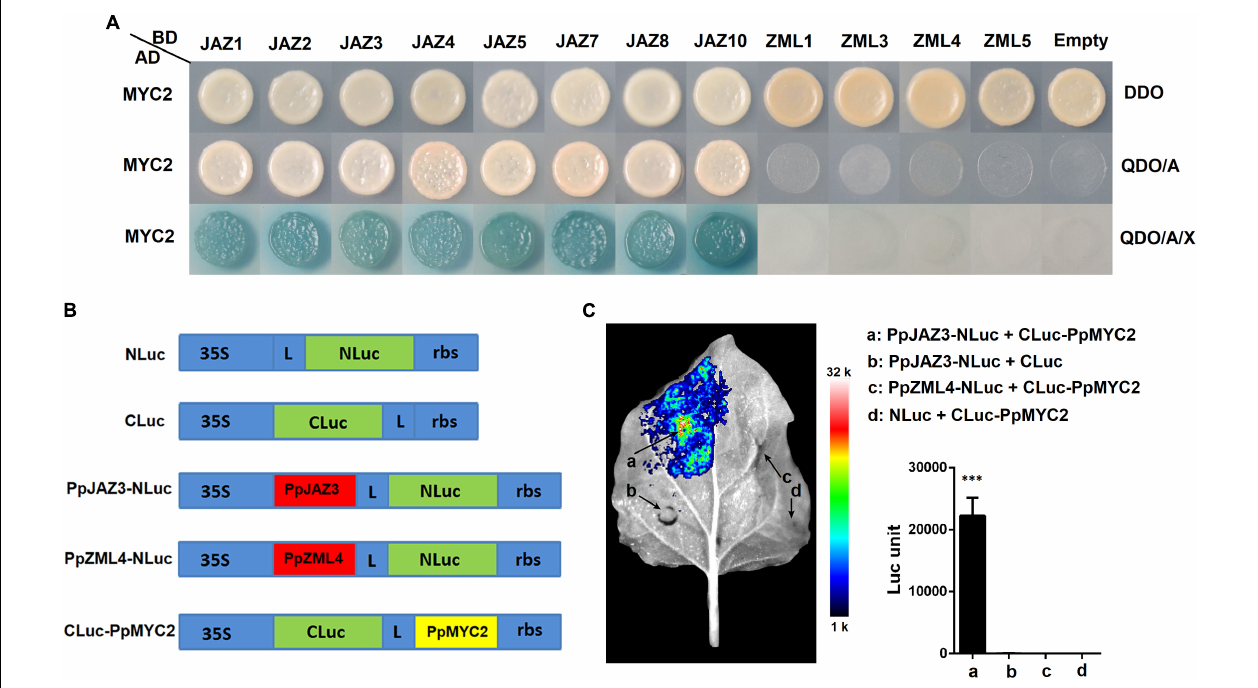
FIGURE 8 | Protein-protein interactions between peach JAZ or ZML proteins with MYC2 transcription factor. (A) Tests of protein interactions by yeast two hybrid system. The positive hybrid yeast cells were grown on SD-Trp-Leu (DDO), SD-Trp-Leu-His-Ade + AbA (QDO/A) and SD-Trp-Leu-His-Ade + AbA media supplemented with X- α -Gal (QDO/A/X) to check the interactions. For more details see the Materials and Methods section. (B) Schematic diagram of the NLuc, CLuc, and NLuc/CLuc derived constructs. L, Gly/Ser linker; rbs, Transcription terminator derived from the Rubisco small subunit gene. The diagram is not drawn to scale. (C) Validation of the protein interaction between PpJAZ3 and PpMYC2 by split firefly luciferase complementation assay. Interactions of four pairs of the NLuc/CLuc derived constructs including “PpJAZ3-NLuc + CLuc-PpMYC2” (a) , “PpJAZ3-NLuc + CLuc” (b) , “PpZML4-NLuc + CLuc-PpMYC2” (c) and “NLuc + CLuc-PpMYC2” (d) were testified by Luc imaging and measurement of the absolute firefly luciferase (Luc) activities. The pseudocolor bar shows the range of luminescence intensity. The error bars represent ± SE of three biological replicates. ∗∗∗ P < 0.001 (Student’s t